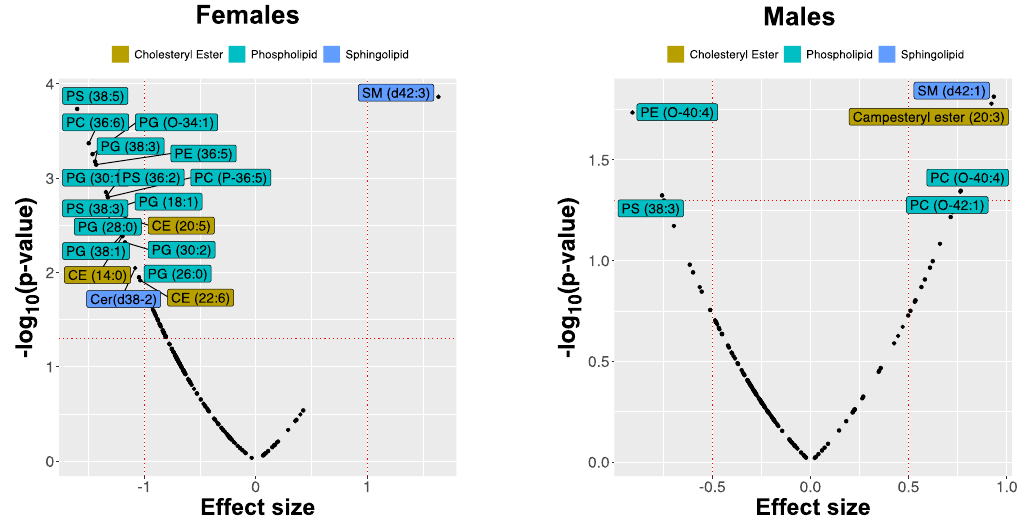
Figure 7. Effect sizes of changes in lipid abundances in the blood of atopic dogs at baseline vs. healthy controls, separated by sex. The effect sizes are represented as standardized mean difference (SMD or Cohen’s d ).